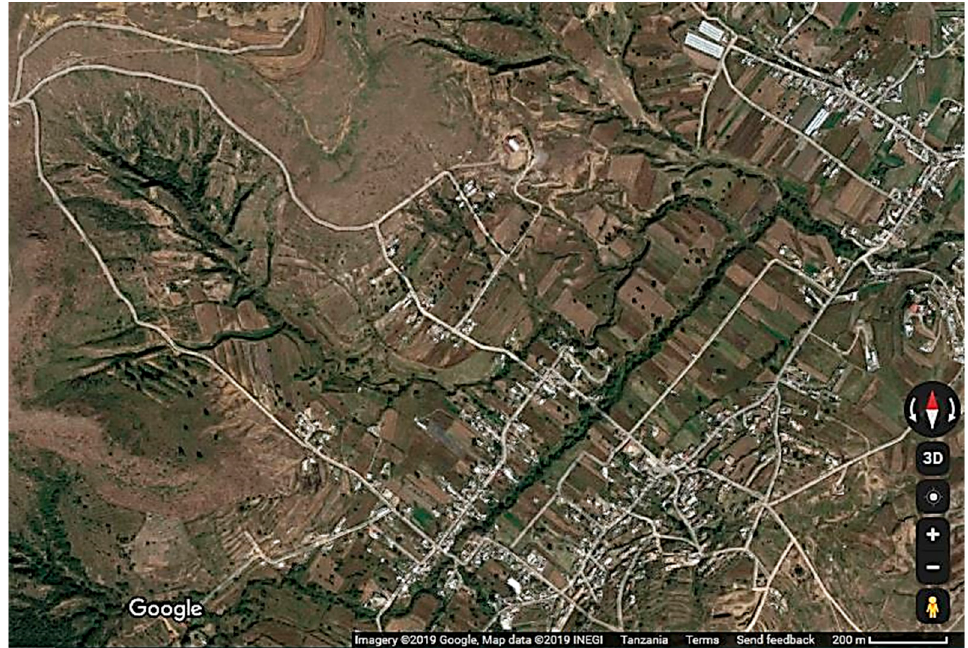
Figure 5. Ejido of Santa Clara Ocoyucan. Source: Google Maps (accessed on 23 July 2019). Land use: Rural–farming land; Tenure System: communal land / ejido ; Stakeholders: Ejidatarios